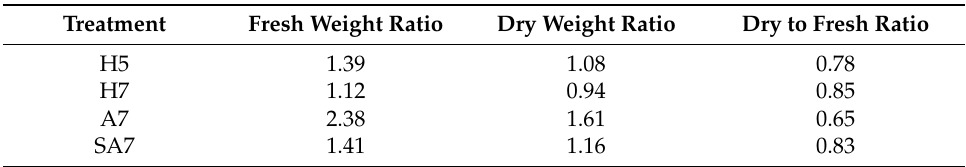
Table 6. Ratio between trials of fresh and dry shoot weights. Ratios were obtained by dividing values for Trial 2 by their corresponding values from Trial